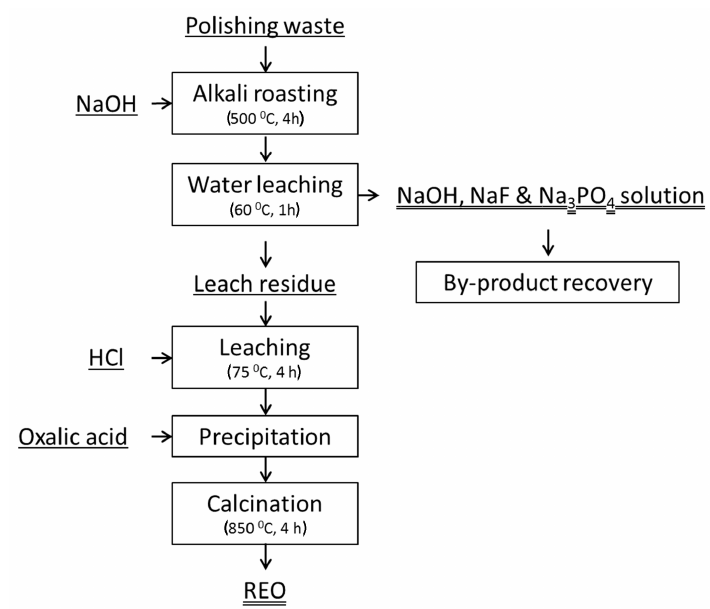
Figure 9. Flowsheet for complete recovery of REEs from polishing waste via an alkali-based process. This flowsheet shows that polishing waste was treated by alkali roasting, followed by acid leaching.